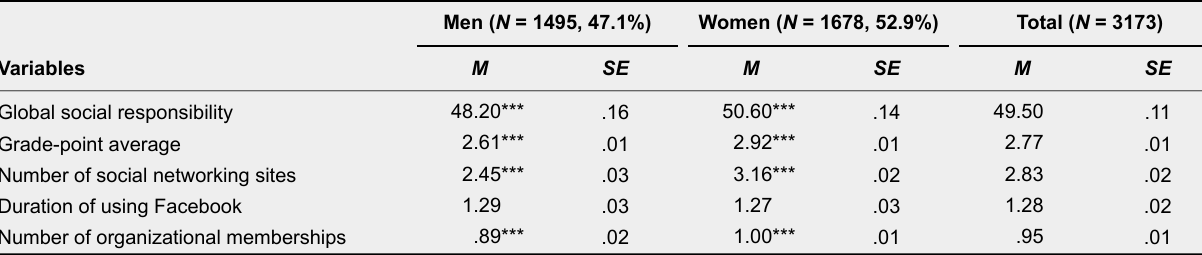
Descriptive Characteristics of